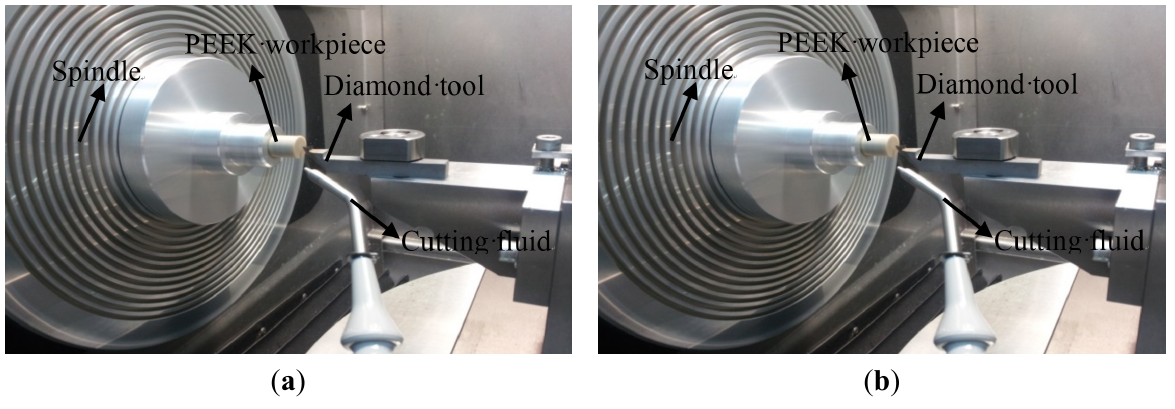
Figure 3. Main sections of the cutting process ( a ) PEEK; ( b ) PEEK CF 30.